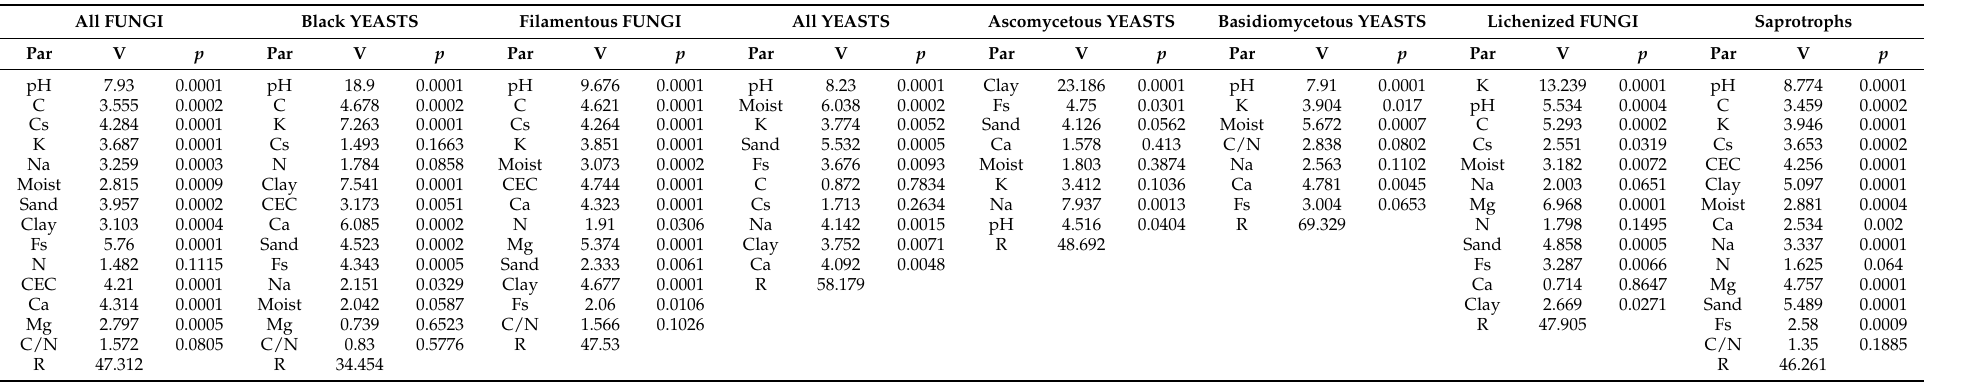
Table 1. Proportion of variation in fungal community composition at the level of the total community (all fungi), the growth form categories, and functional guilds explained by soil physicochemical parameters added sequentially (first to the last) in a model, depending on their independent influence in the variance, as reported in Table S6. Par: soil parameters; V: variance; P: p value; R: residuals; Cs: Coarse silt; Fs: Fine silt; Moist: